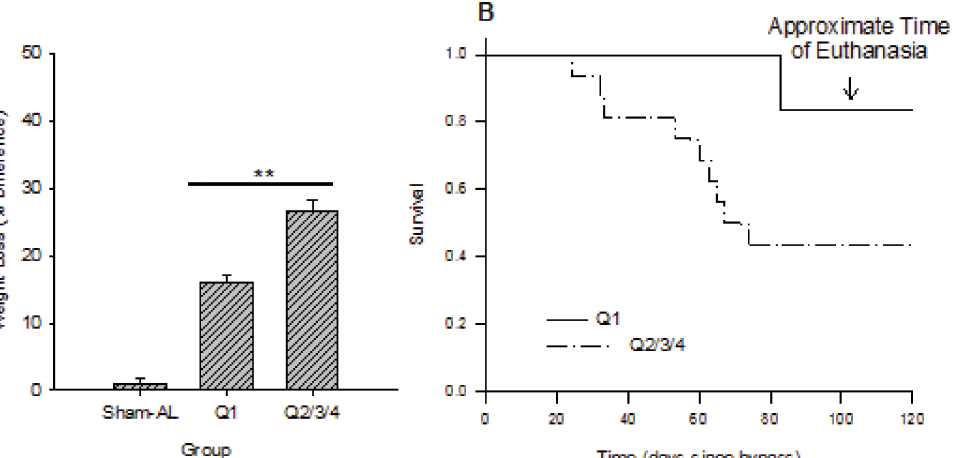
Fig 3. Objective health-screen and bypass outcome. As gross health and weight were highly variable in the experimental group, compared to the sham- operated controls, relative weight-loss after gastric bypass was calculated and used to objectively determine these animals ’ health. (A) The 7 RYGB animals with the lowest and most stable weight-losses (Q1) were compared to the remaining 75% ( ** p < 0.01 compared to each other; Sham-AL shown as reference). (B) This objective separation was valid, as differences in mortality were explained by the